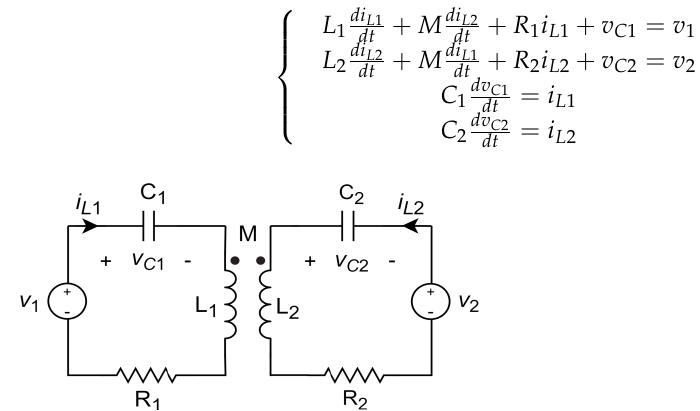
Figure 15. AC equivalent circuit of the IPT stage.